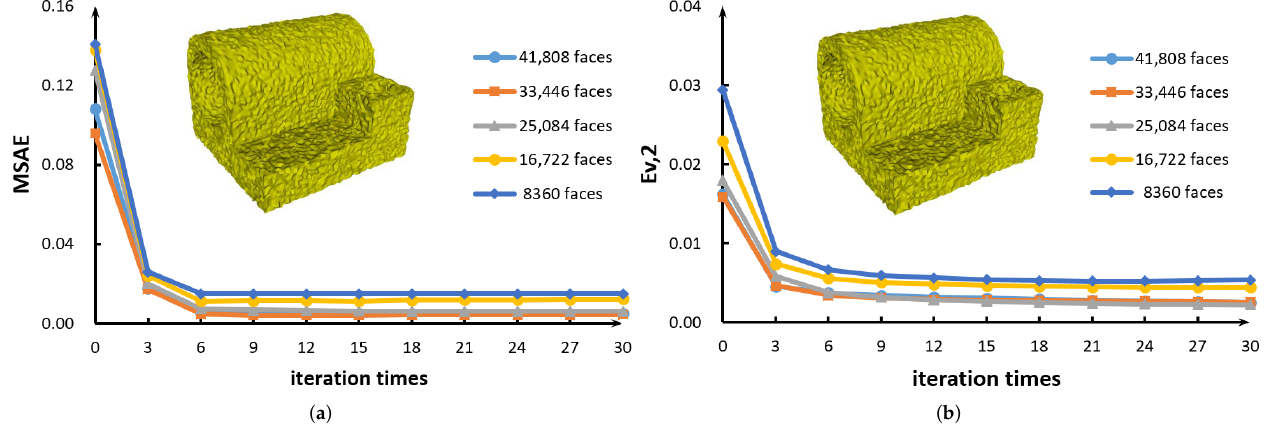
Figure 12. ( a ) Error curves of MSAE for Joint model with five different resolutions. ( b ) Error curves of E v ,2 for Joint model with five different